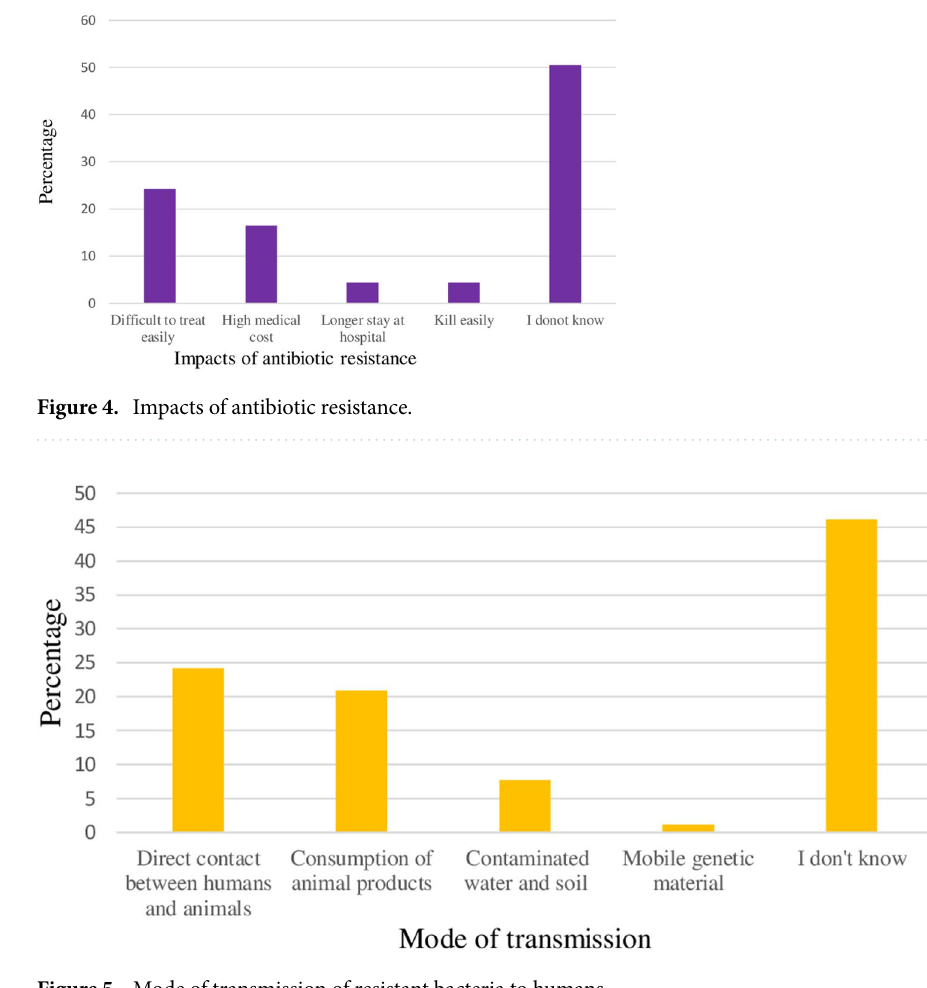
Figure 5. Mode of transmission of resistant bacteria to